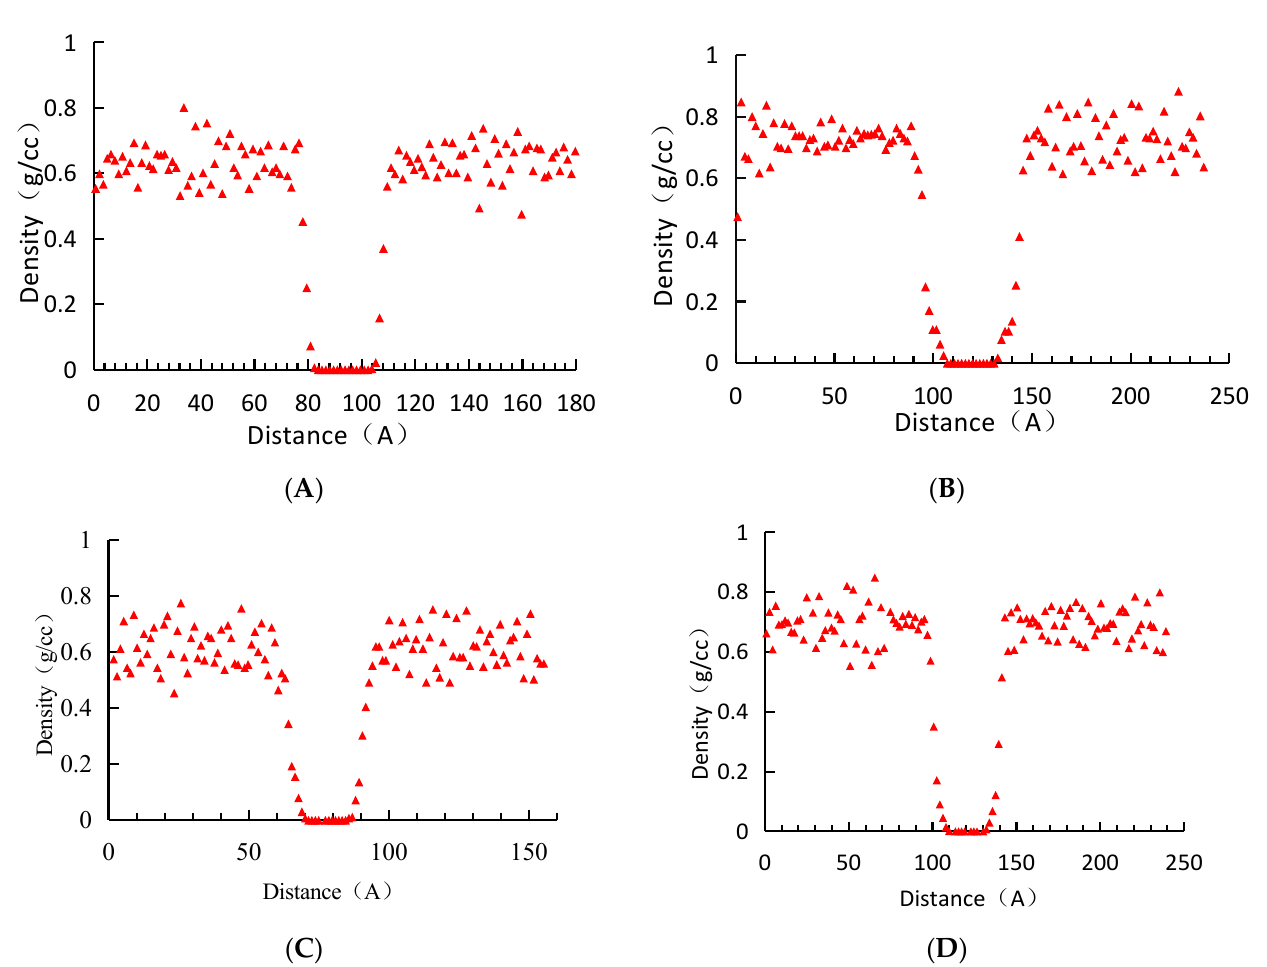
Figure 10. Density distribution of oil film molecules with different molecular structures. ( A ) Molecular density distribution of C 7 H 14 crude oil containing chain-like C-C double bonds. ( B ) Molecular density distribution of C 7 H 14 crude oil containing cyclane. ( C ) Molecular density distribution of C 7 H 16 crude oil containing chain-like saturated hydrocarbon. ( D ) Molecular density distribution of C 7 H 12 crude oil containing chain-like C-C triple bond.